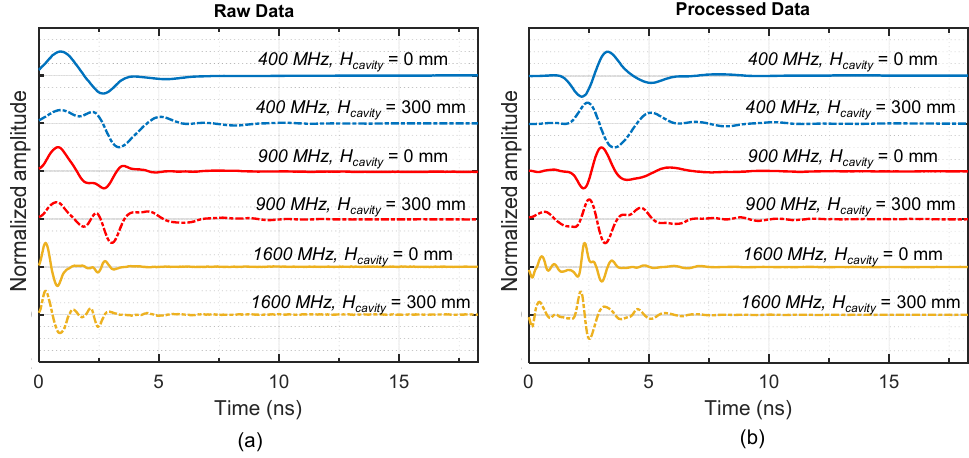
Figure 6. Typical GPR signals measured on the section 4 (non-cavity region) and section 5 (defected test region with a 300 mm thick air-cavity) behind 100 mm concrete by the three GPR antennas (400 MHz, 900 MHz, and 1600 MHz), presented as blue, red, and yellow lines, respectively: ( a ) raw GPR signals and ( b ) processed GPR signals.